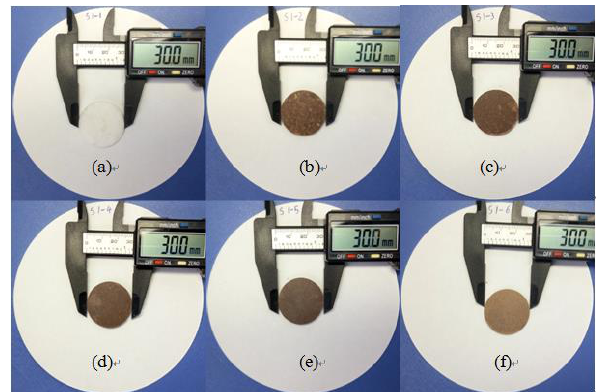
Figure 2. Sample tablets of CA/CIT composites used in leakage tests. ( a ) S1-1, ( b ) S1-2, ( c ) S1-3, ( d ) S1-4, ( e ) S1-5, ( f ) S1-6.